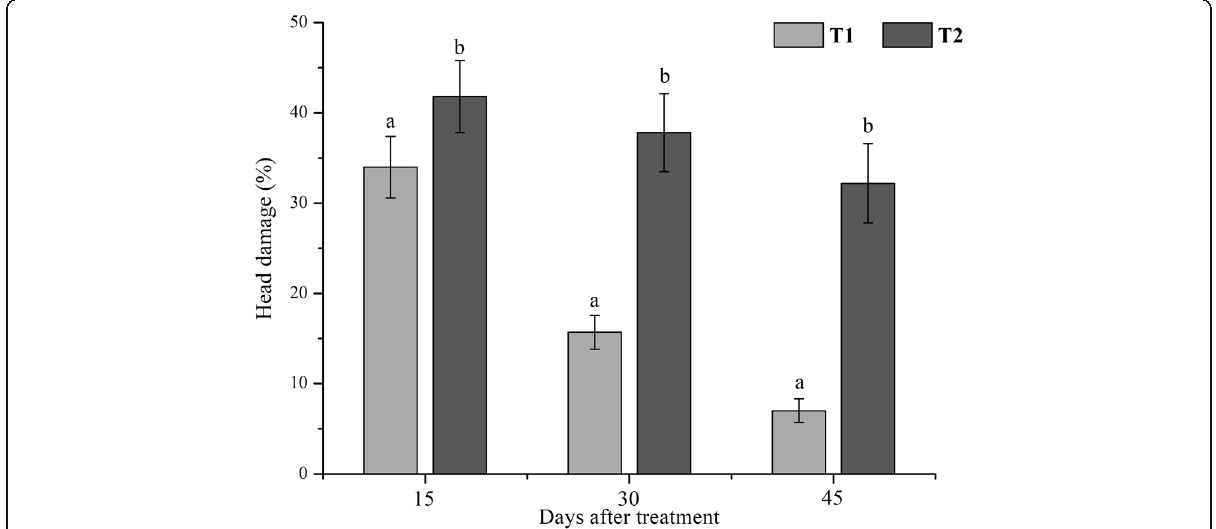
Fig. 3 Effect of biocontrol-based IPM and farmers ’ practice on percentage head damage of cabbage at 15, 30, and 45 days after treatment. Different letters on the top of error bars indicate statistically different values for different treatments using Tukey ’ s test ( P < 0.05). Bars = standard error, T1 = biocontrol-based IPM, T2 = farmer ’ s